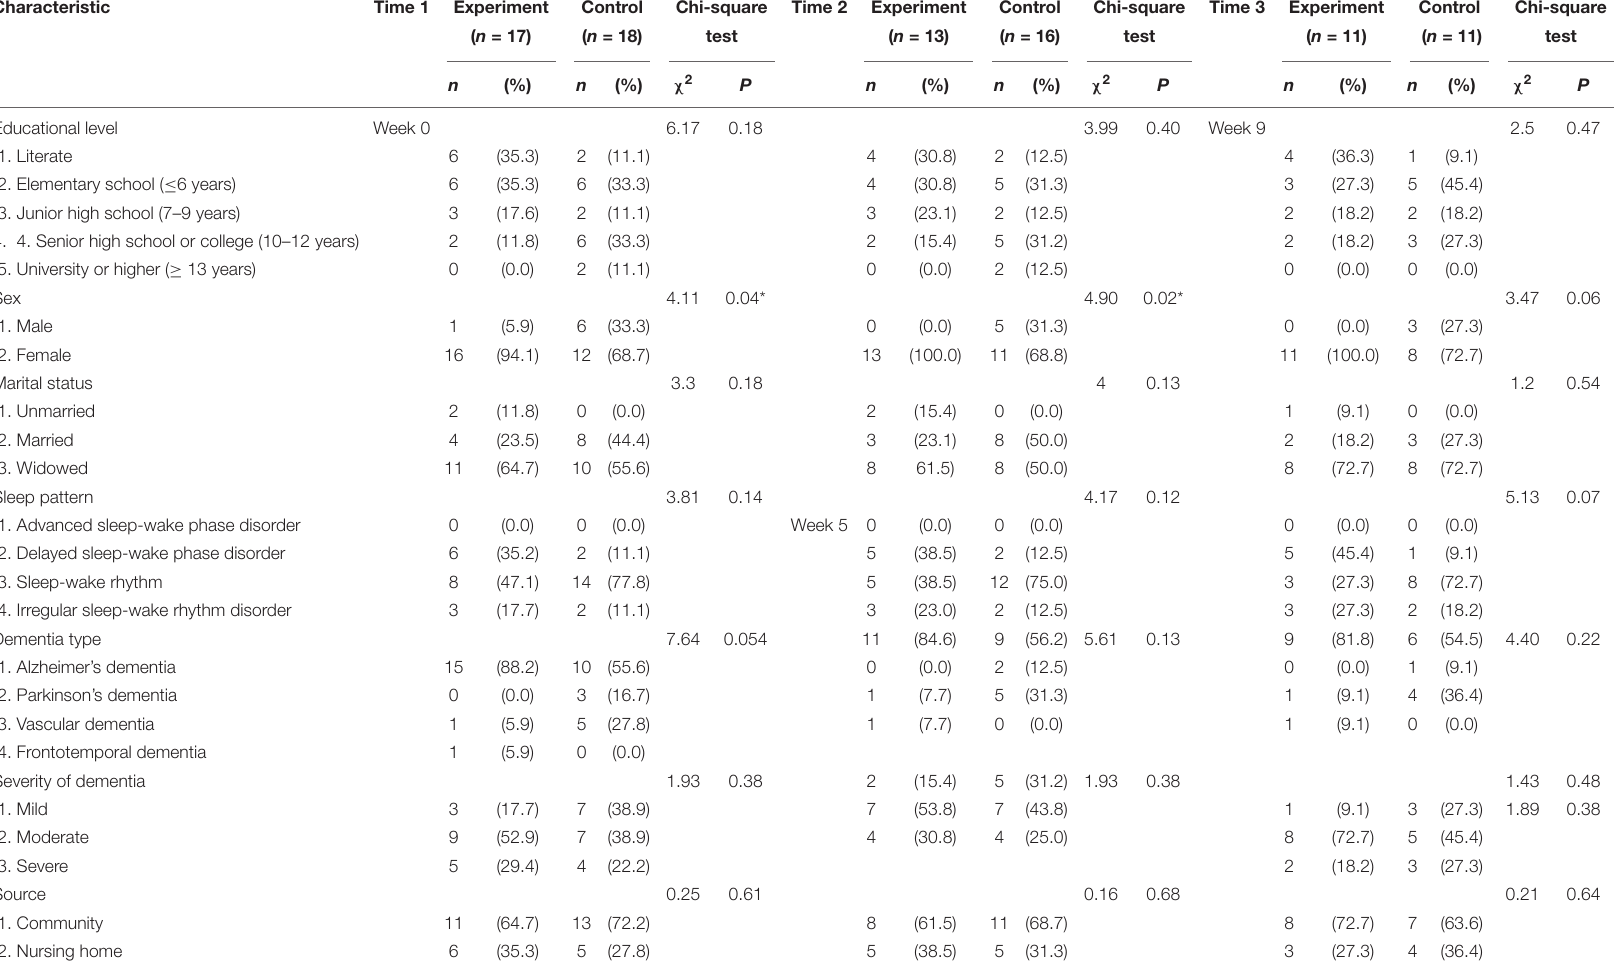
TABLE 1 | Between-group comparisons of the demographic data at baseline, the 5th week, and the 9th week.